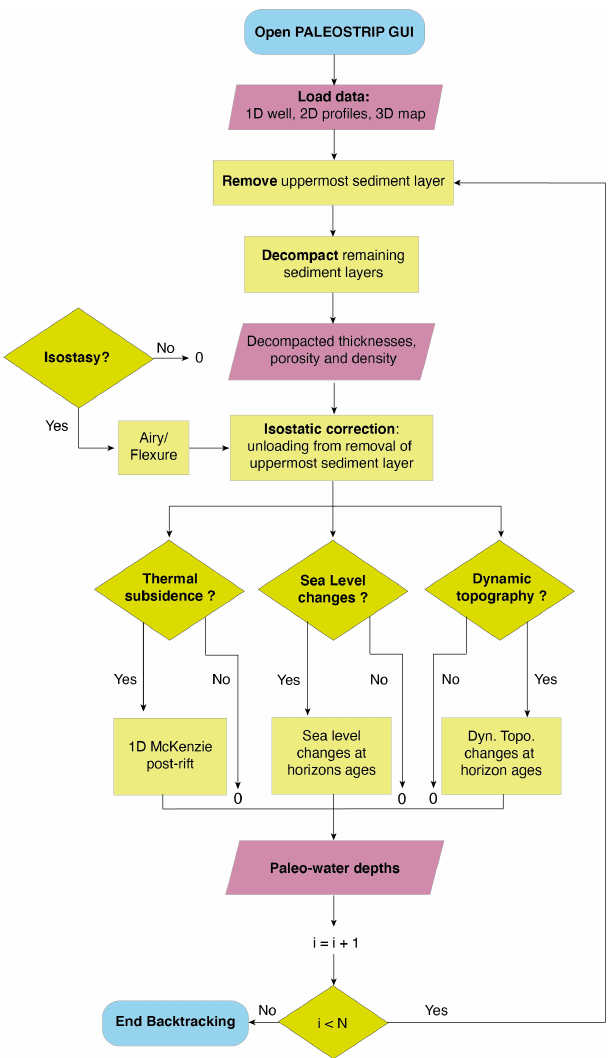
Figure 4. The 2D and 3D domain expansions for computation of flexural isostasy. (a) In the case of 2D vertical sections, input data are extended with the edge values for 90% of the initial total array length (NX). This extended array is placed at the centre of a null array that is 3 times larger than the initial input data array. (b) In the case of 3D maps, input data are extrapolated with a nearest neigh- bour algorithm on a mesh grid (black) to obtain a structured squared grid if the initial data are given on an irregular polygon. This mesh grid is extended by 30% on all edges (red) and is placed at the cen- tre of a grid twice as large as the mesh grid obtained from initial input data